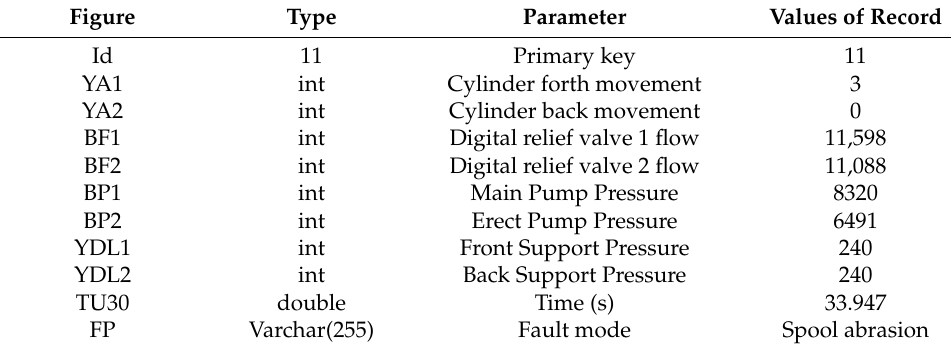
Table 2. Example of case data from the hydraulic control